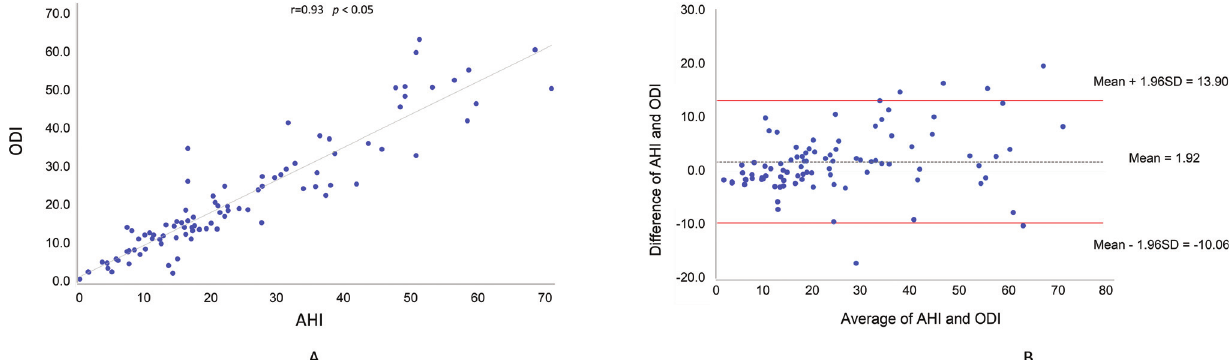
Figure 1 - Correlation between the oxyhemoglobin desaturation index (ODI) and the apnea-hypopnea index (AHI) in the entire sample (a). Bland-Altman plot showing the comparison between AHI and ODI with confidence interval of 95% (b).